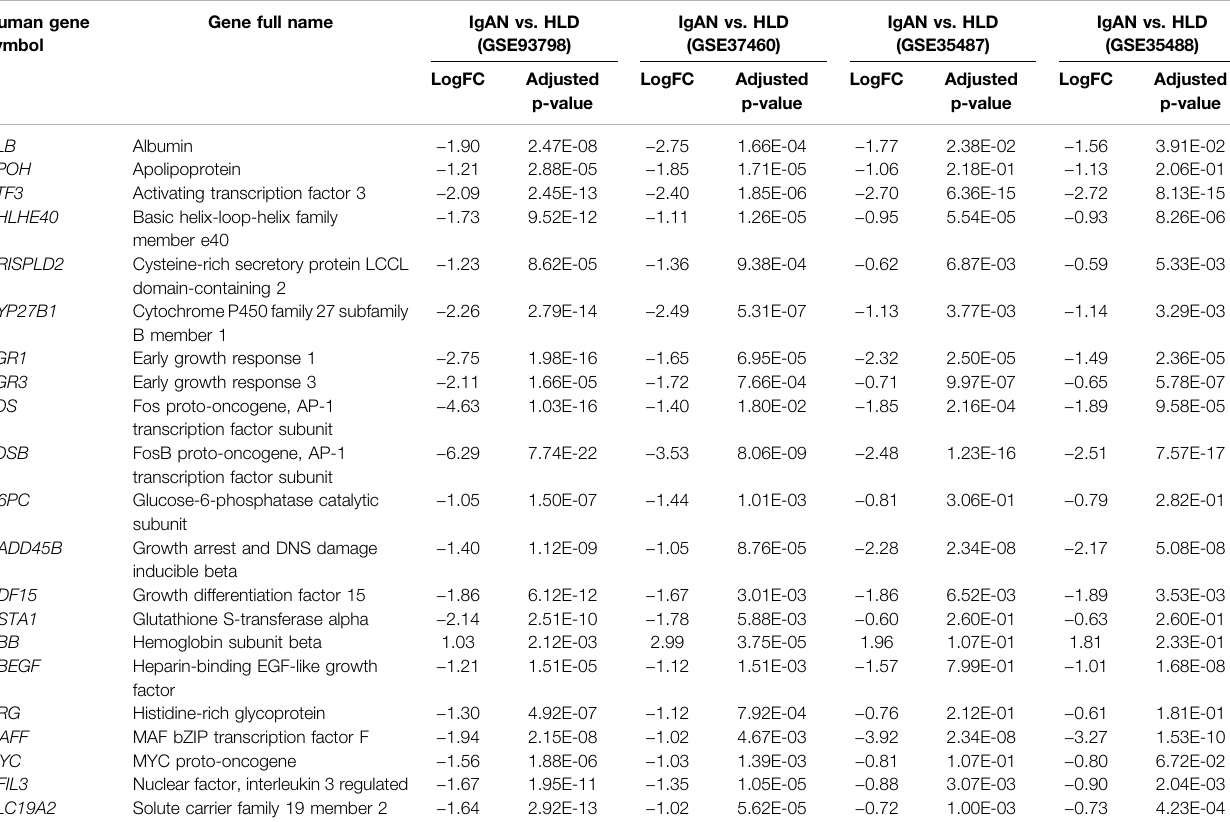
TABLE 1 | Overlapping DEGs among all selected four GEO datasets. Human gene